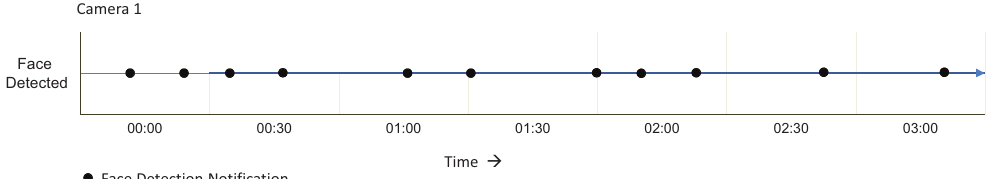
Figure 19. Camera 2 video stream monitor against the service Face Detection for three hours.